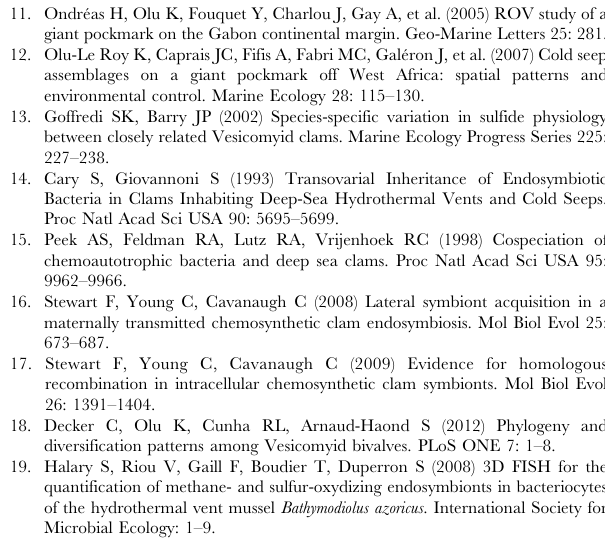
Figure S2 aprA maximum-likelihood tree for symbiont bacteria. The evolutionary model tested was GTR + I + G (proportion of invariable sites= 0.22, number of substitution rates =6, gamma distribution parameter = 0.72). Bootstrap values for 1000 replicates are given in percent above branches and clades ( . 70% only). Scale bars expressed as the number of substitutions per base pair. (TIF) Figure S3 Cross-sections of gills dissected from C. regab (1) and L. chuni (2) (1: 225-V3 and 2: 225-V1) with individual channels for DAPI (in blue) (a), Creg821 (stained in red) (b), Lchun821 (stained in green) (c) and a composite image of all three channels